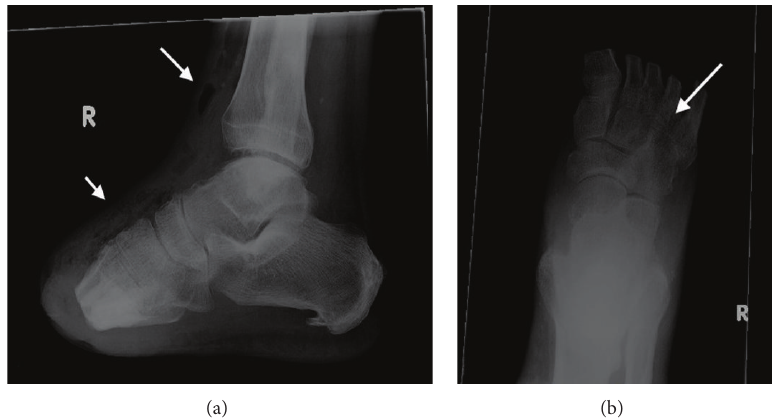
Figure 1: Right foot radiographs reveal extensive soft tissue gas in the dorsum of the foot ((a), short arrow) and anterior to the distal tibia ((a), long arrow). Anteroposterior view demonstrates discrete radiolucencies in the metatarsals remnants ((b), arrow) and midtarsal bones. Previous transmetatarsal amputation is noted.